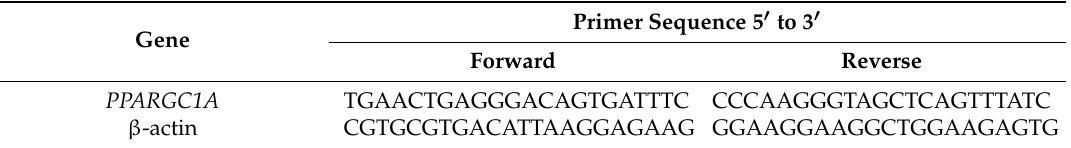
Table 1. Primers sequences used for qPCR in this